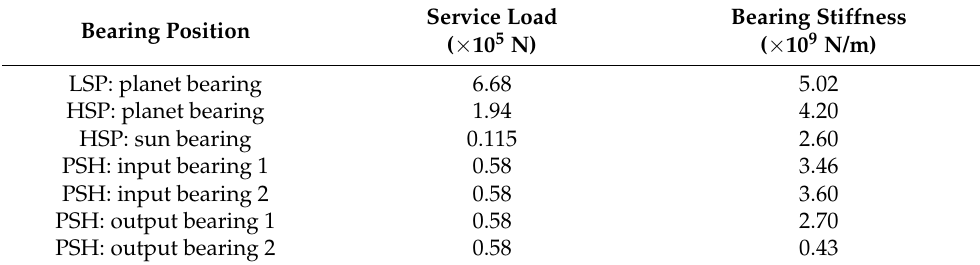
Table 6. Parameter identification results of the